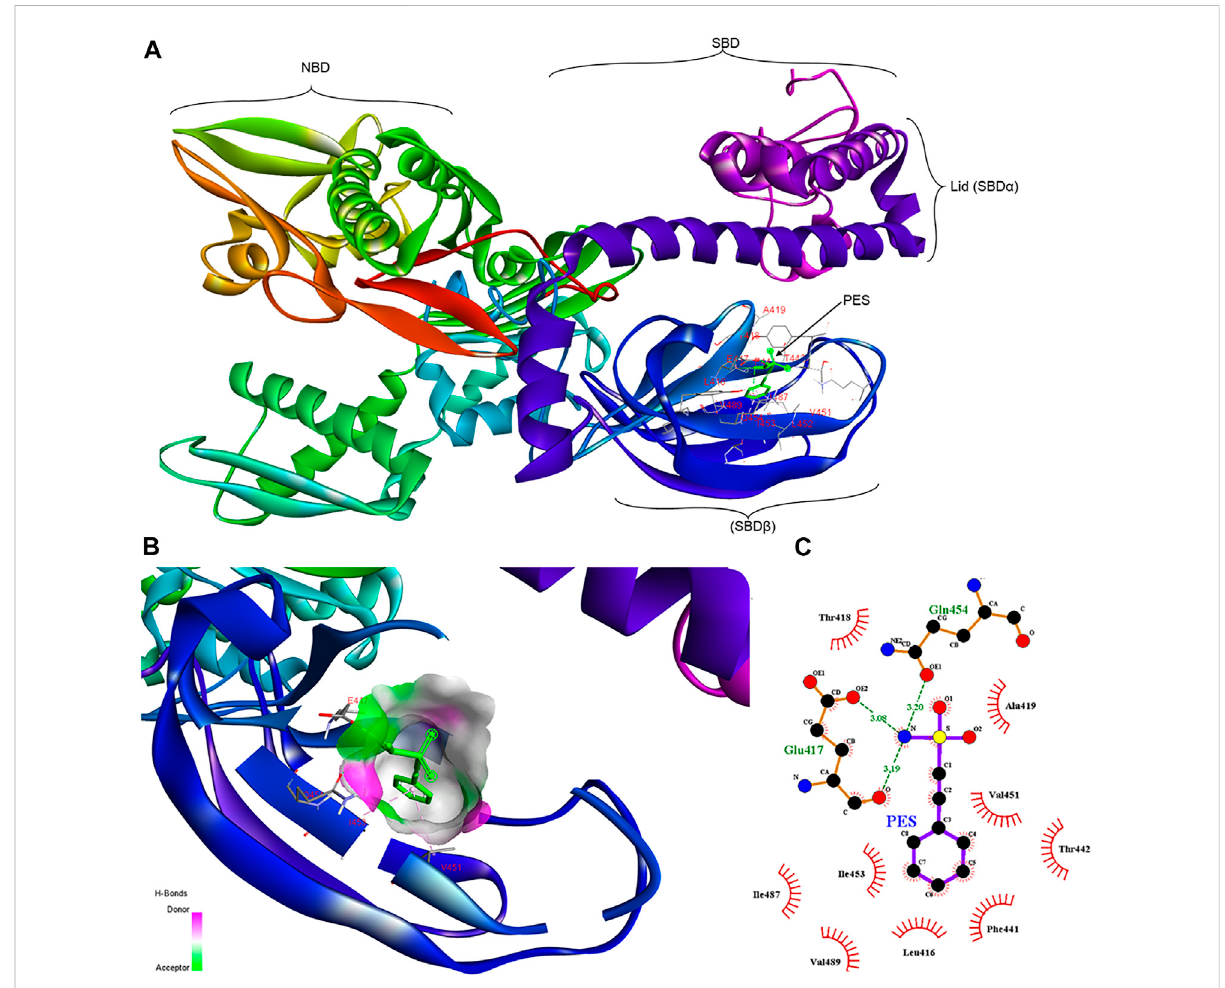
FIGURE 2 Schematic representing the interaction of PES with PfHsp70-1. (A) representation of a three-dimensional model with a ribbon structure of full- length PfHsp70-1 bound to PES through the SBD β . The different domains of PfHsp70-1 are also shown. (B) Surface and ribbon views of the docked structures, showing the residues involved in the interaction, and (C) a 2D diagram showing receptor-ligand interface. PES makes H bond contacts with Glu417, Gln454 of PfHsp70-1. In addition, PES exhibits pi-alkyl contacts with Val451 and Ile453 of